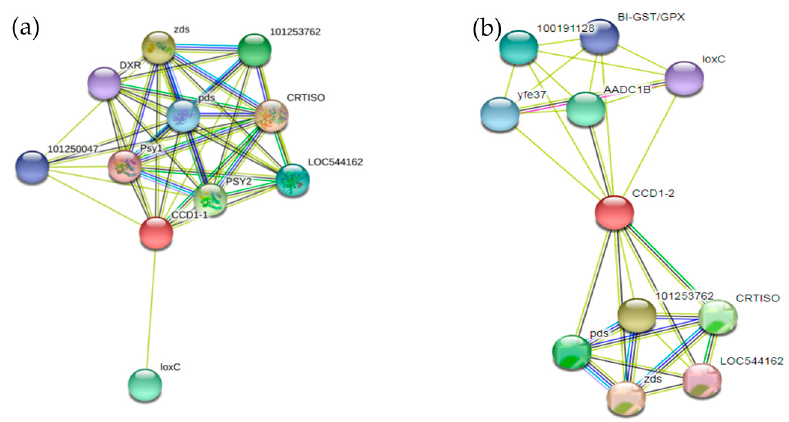
Figure 8. Diagram of interaction networks of the SlCCD1A and SlCCD1B proteins: ( a ) the SlCCD1A protein and ( b ) SlCCD1B protein.